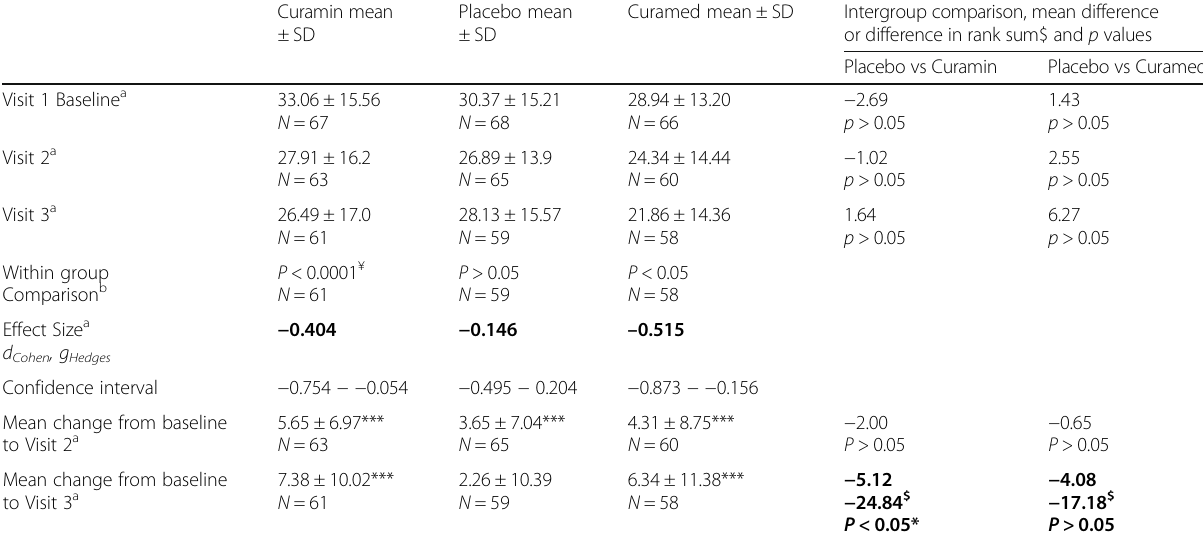
Table 4 Within (columns) and between (lines) group comparisons of WOMAC Total score (%) Curamin mean Placebo mean Curamed mean ± SD Intergroup comparison, mean difference ±SD ± SD or difference in rank sum$ and p values Placebo vs Curamin Placebo vs Curamed